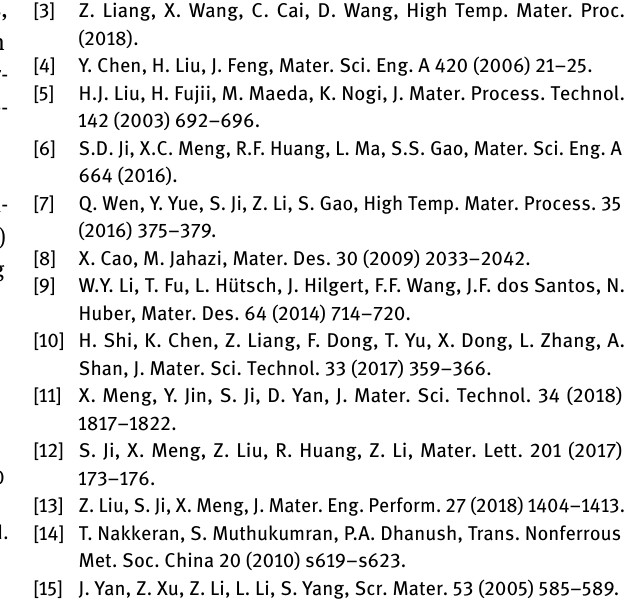
(4) The SSFSW has potential to join dissimilar materials, such as Al/Mg alloys, Al/copper alloys,